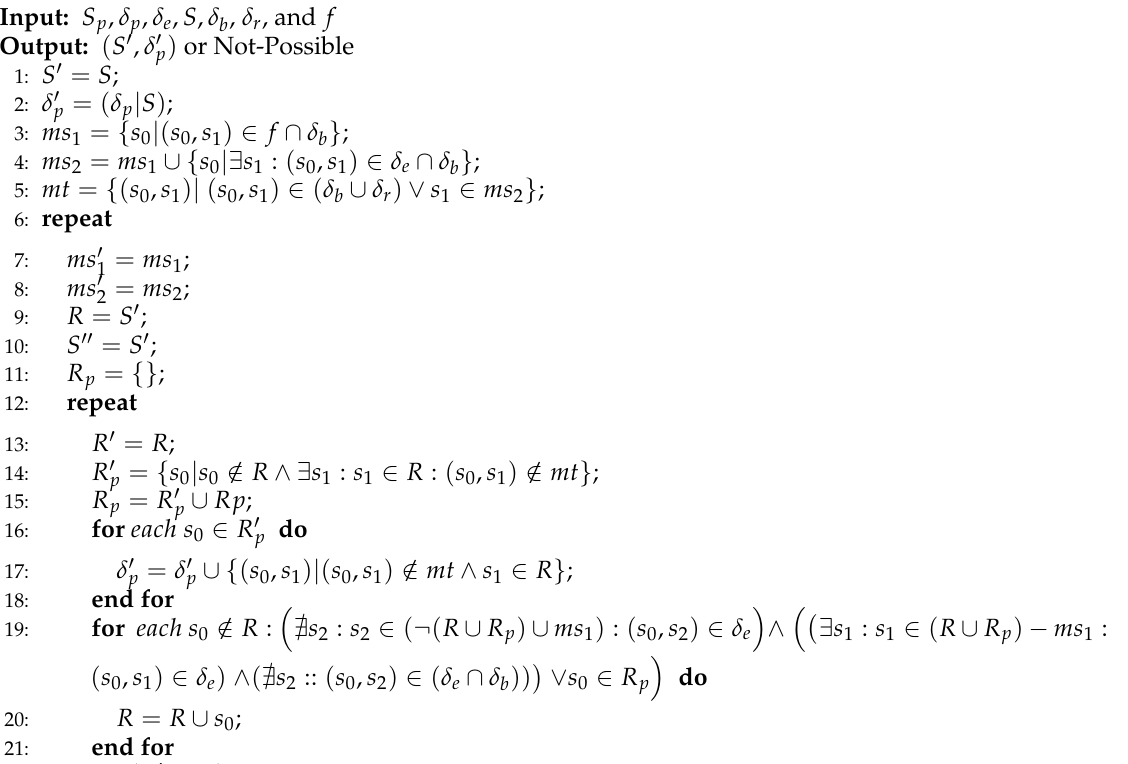
Algorithm 3 Adding Masking